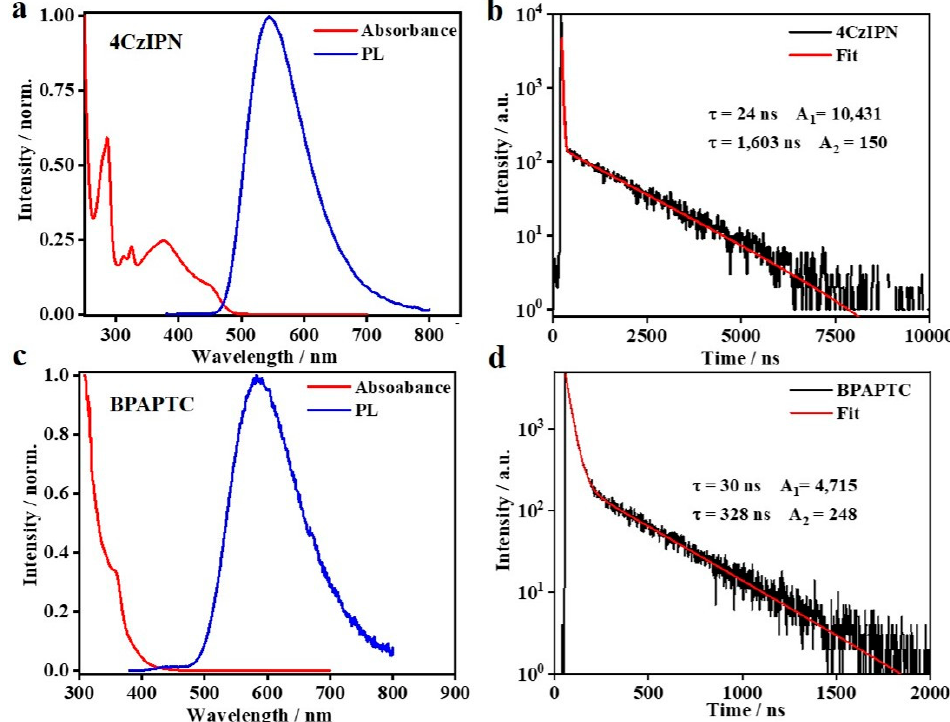
Figure 1. The photophysical results of these two compounds in DCM: normalized UV–Vis absorbance and PL spectra ( a ) and PL transient curve ( b ) of 4CzIPN solution in DCM (25 μ M); Normalized UV–Vis absorbance and PL spectra ( c ) and PL transient curve ( d ) of BPAPTC solution in DCM (25 μ M).